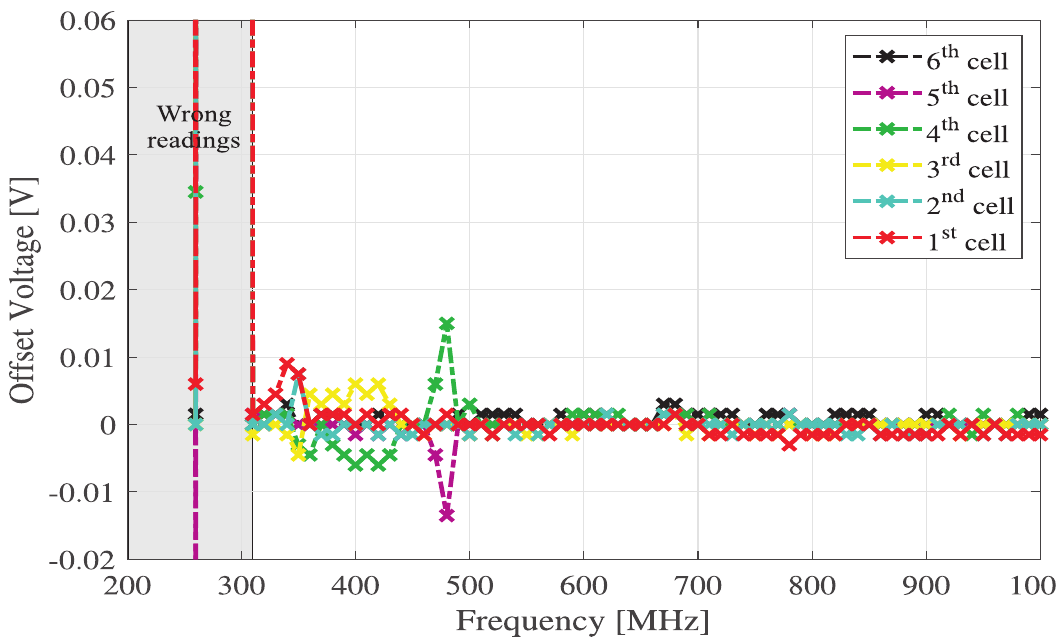
Figure 16. EMI-induced offset in the cell voltage readings. Antenna in front of the cable. Horizontal